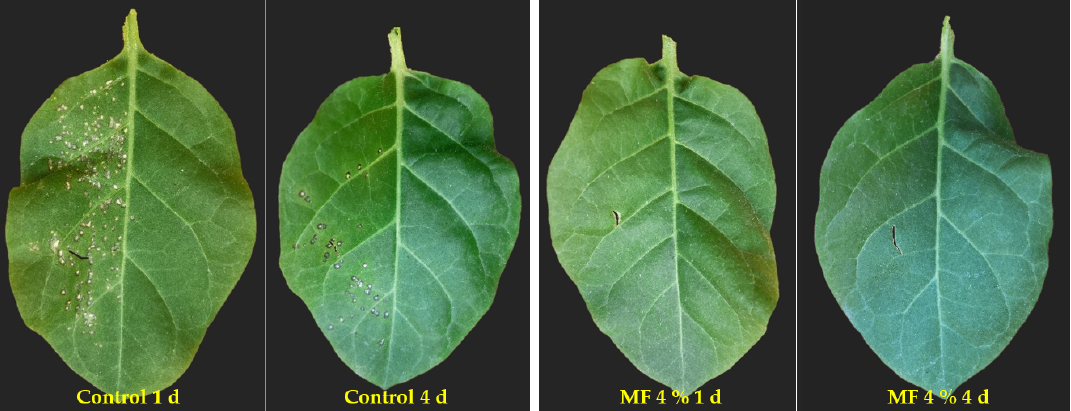
Figure 6. Comparative illustration of the efficacy of water and Menno Florades (4%) against ToBRFV within a disinfection mat for 1- and 4-days contact time, on the indicator plant Nicotiana tabacum cv. Xanthi NN. ‘Control’ = dirt + deionized water (1:8 v:v ); ‘MF’ = dirt + Menno Florades (1:8 v:v ); ‘1d’ = one day contact time; ‘4d’ = four days contact time.